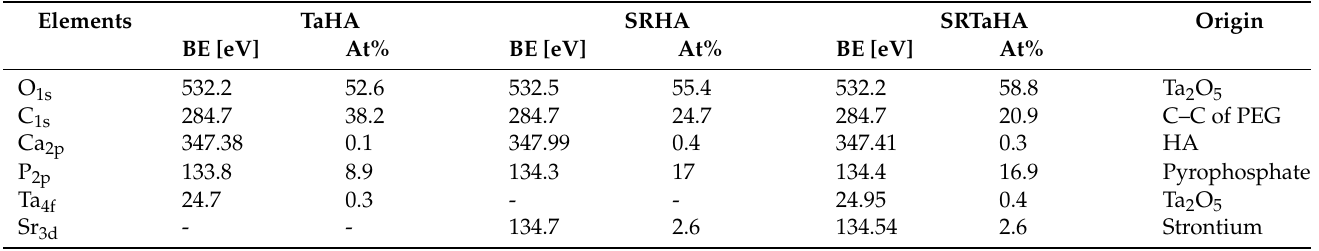
Figure 9. Surface profile and surface roughness plots for HA combination coating samples. Table 4. Binding energy (BE) and atomic percentage of the elements present at the coated